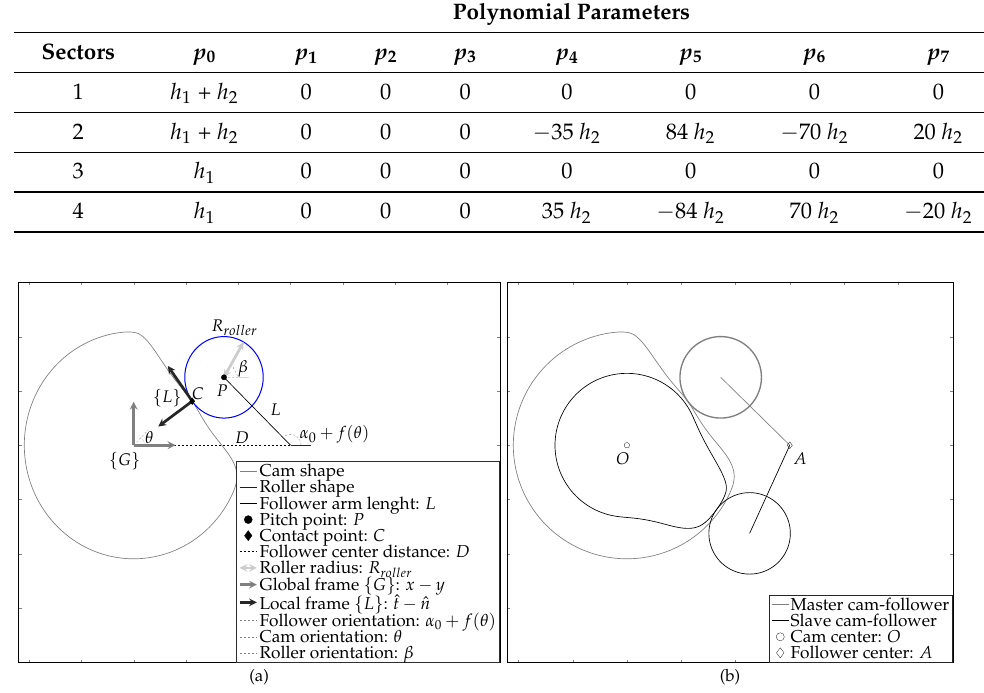
Figure 3. ( a ) Cam-follower nomenclature and ( b ) conjugate cam-follower